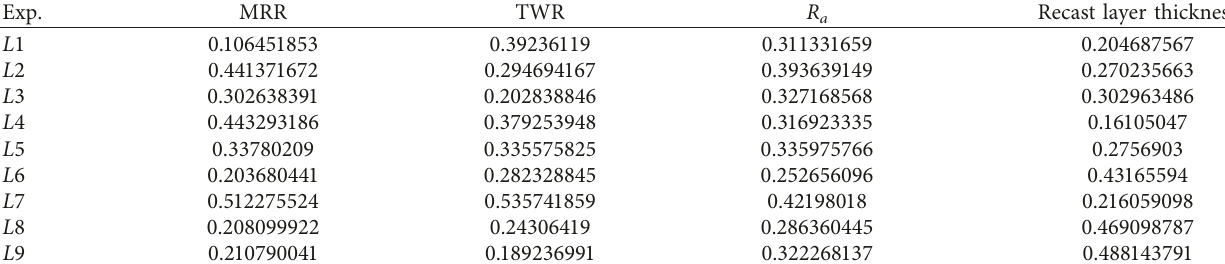
Table 5: Normalized decision matrix.